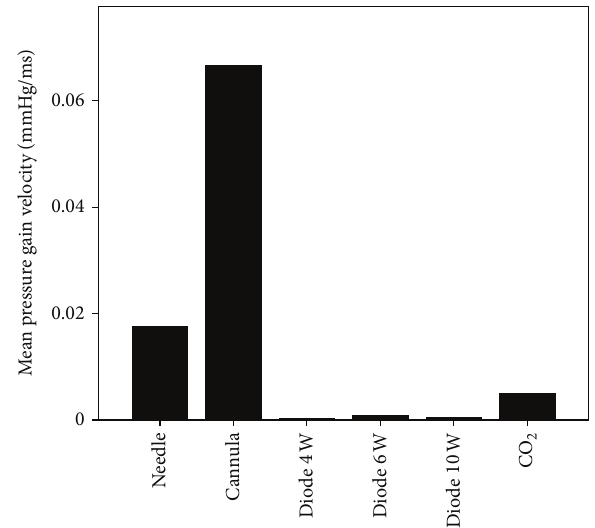
Figure 5: Mean pressure gain velocity for opening of the round window